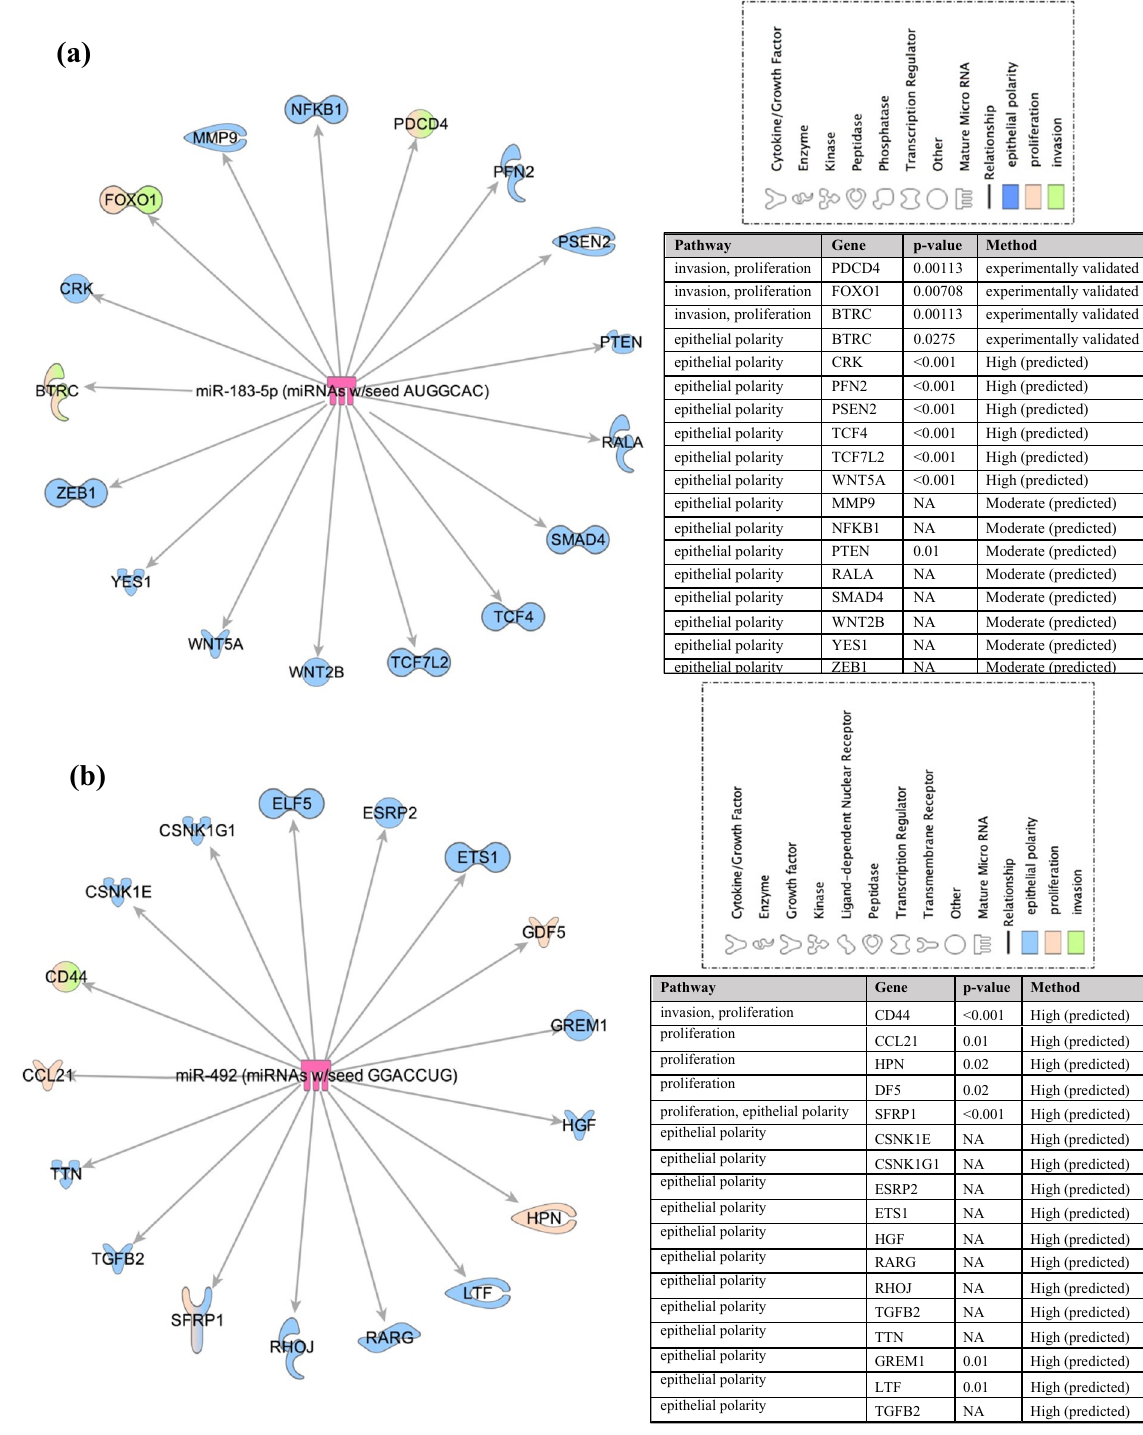
Figure 5. Potential downstream targets of miR-183 and miR-492 involved in pre-tumorigenic pathways. IPA was used to plot the predicted mRNAs (with high and moderate confidence) and experimentally validated mRNA targets downstream of ( a ) miR-183-5p and ( b ) miR-492 that are involved in pre-tumorigenic pathways like epithelial polarity, invasion and proliferation pathways in breast cell lines and tissue